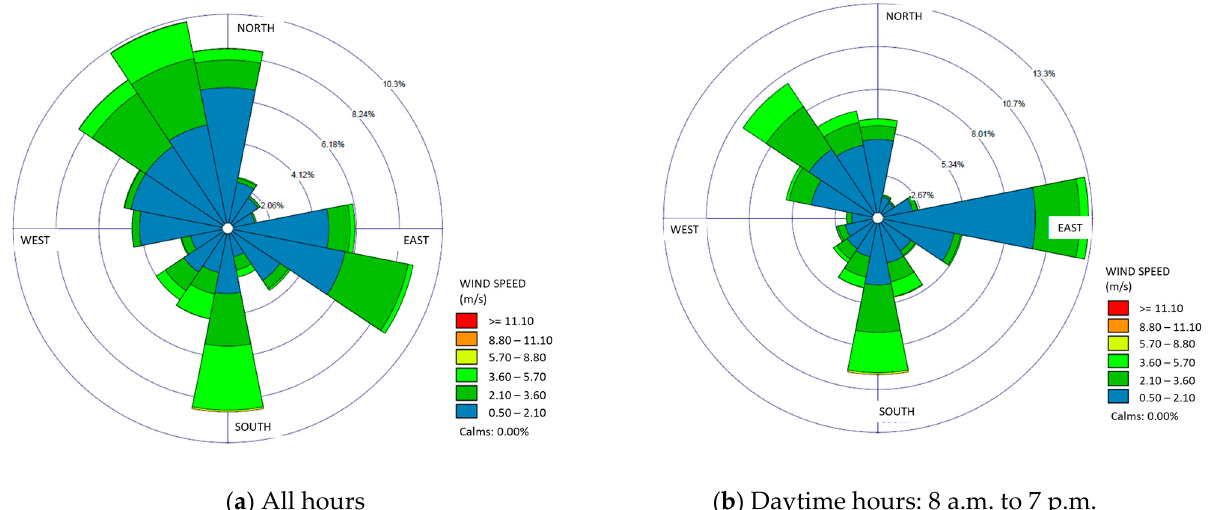
Figure 2. Three-year period (2014–2016) data wind rises obtained from the meteorological measured data at the station located near the study area for ( a ) all hours and ( b ) daytime hours.